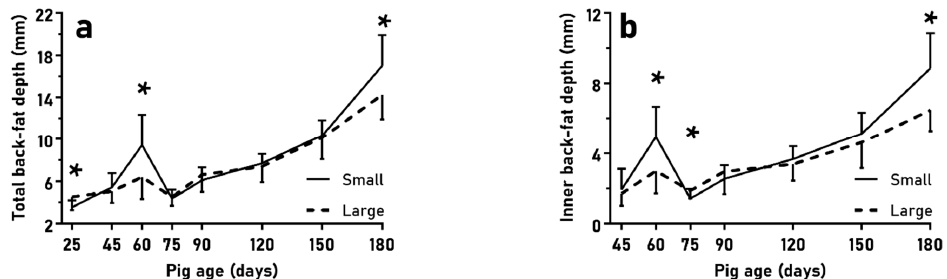
Figure 4. Mean values ( ± SD) of total and inner-layer back-fat depths ( a , b ) over the course of juvenile development (25 to 180 days old) when comparing normal birth-birth (NBW) piglets from small ( n = 16) and large litters ( n = 18). Asterisks indicate significant differences (* p < 0.05, ** p < 0.01). In the second trial (BIRTH-WEIGHT), NBW and LBW pigs had similar ADWG without differences ( p > 0.10). Pigs with LBW only showed greater fractional growth rates from 25 to 75 days old and overall (46.3 ± 6.5 vs. 39.5 ± 8.9 g/kg, p < 0.05; and 242.6 ± 47.8 vs. 191.4 ± 24.9 g/kg, p < 0.01; respectively). NBW pigs maintained higher values for body weight and size without different evolution until 150 days old, when no significant differences were found ( p > 0.10 ; Figure 5). The loin diameter was also greater in NBW piglets than in LBW piglets, with significant differences at 75 days old (14.2 ± 1.8 vs. 12.7 ± 1.2 mm; p < 0.05), but without differences in adiposity ( p > 0.10) nor at other time points ( p > 0.1 ; further data in Supplementary File S1). Again, there were no sex effects ( p > 0.10).